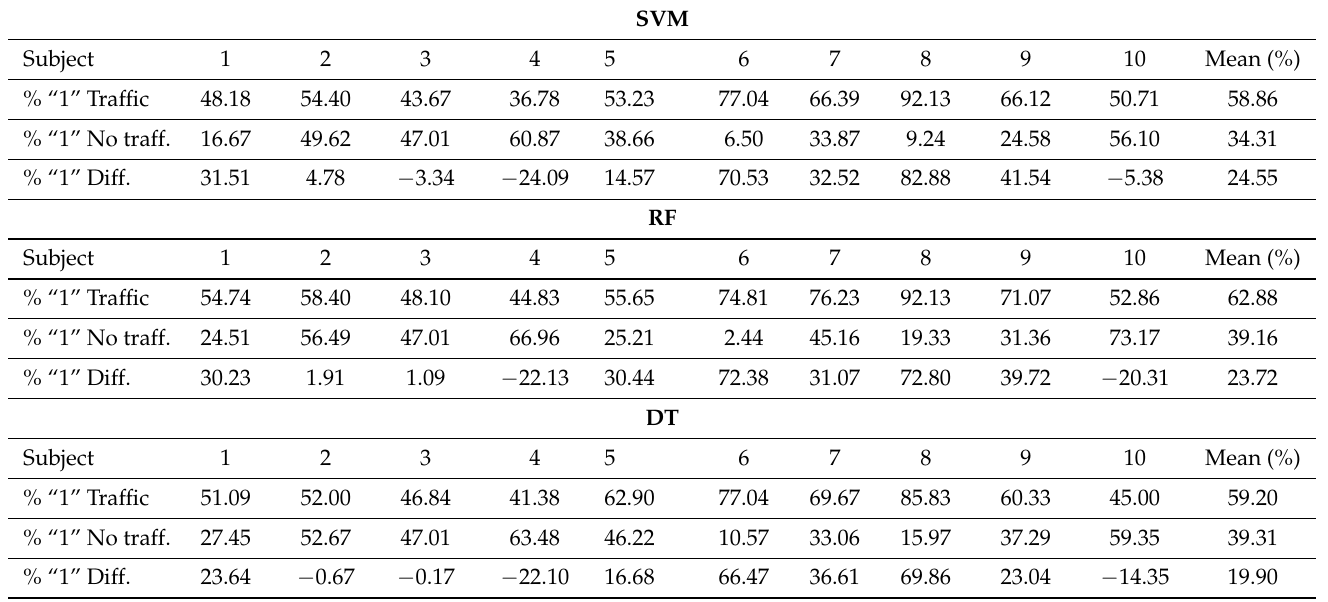
Table 3. Total number of intervals identified as “stress” (in %) for each classifier and each subject in the two driving situations. The numeric difference between them (with traffic–no traffic) is also displayed.